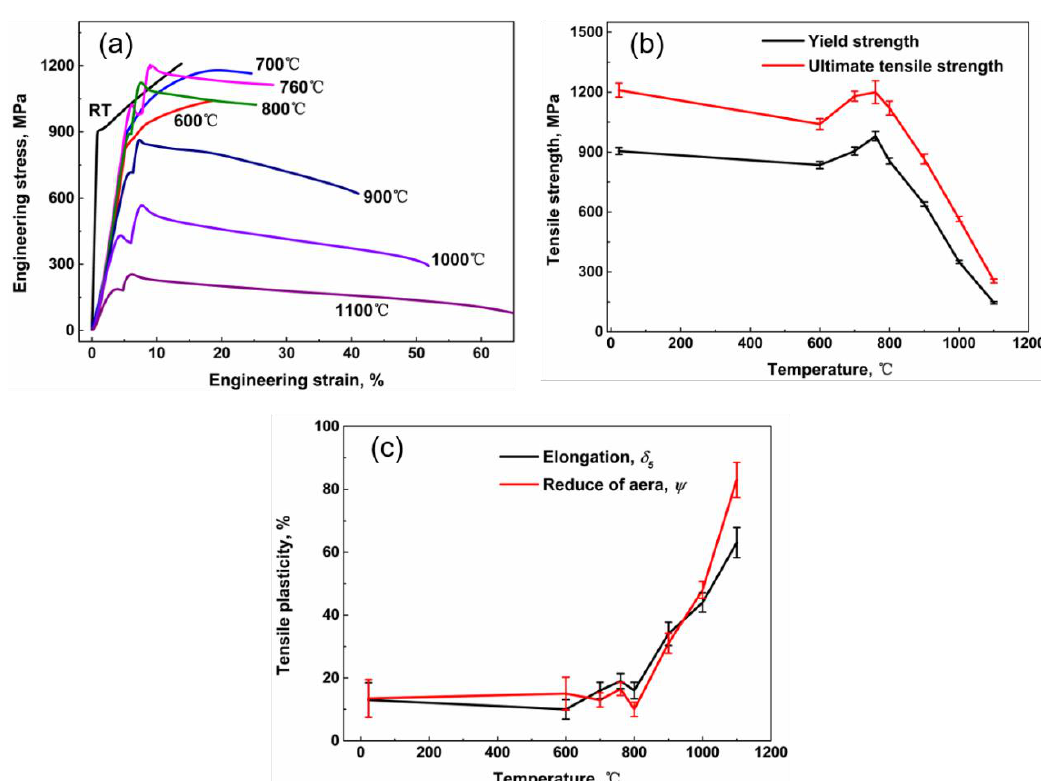
Figure 2. Tensile properties of DZ951G alloy. ( a ) Engineering stress–engineering strain curves; ( b ) strength with various temperatures; ( c ) plasticity with various temperatures.